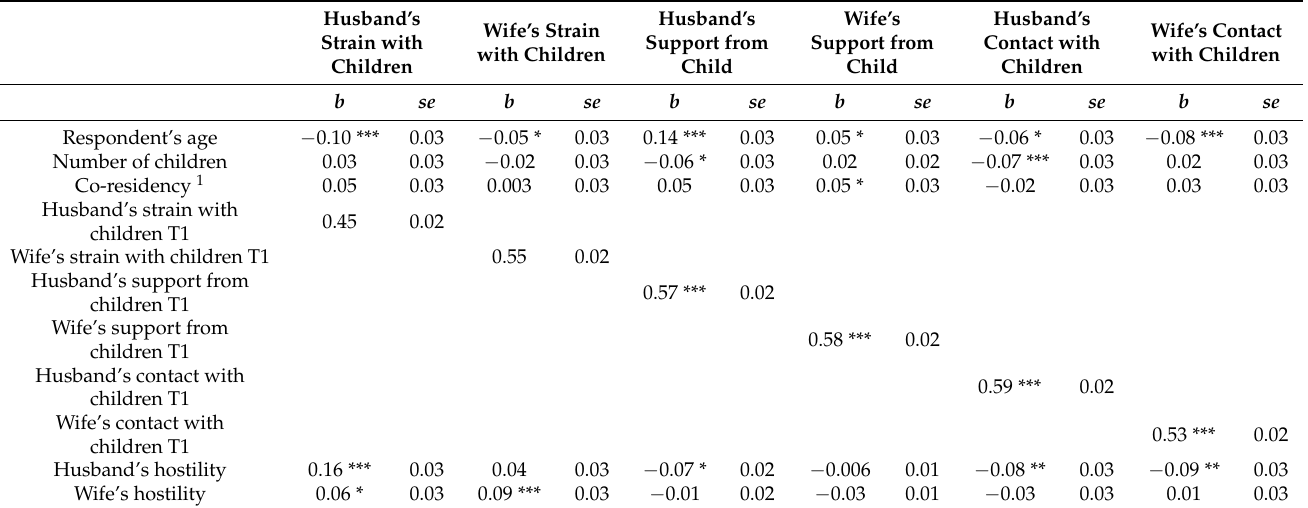
Table 2. Dyadic analysis of husband and wife strain in their relationships with their children. Husband’s Husband’s Wife’s Husband’s Wife’s Strain Wife’s Contact Strain with Support from Support from Contact with with Children with Children Children Child Child Children b se b se b se b se b se b